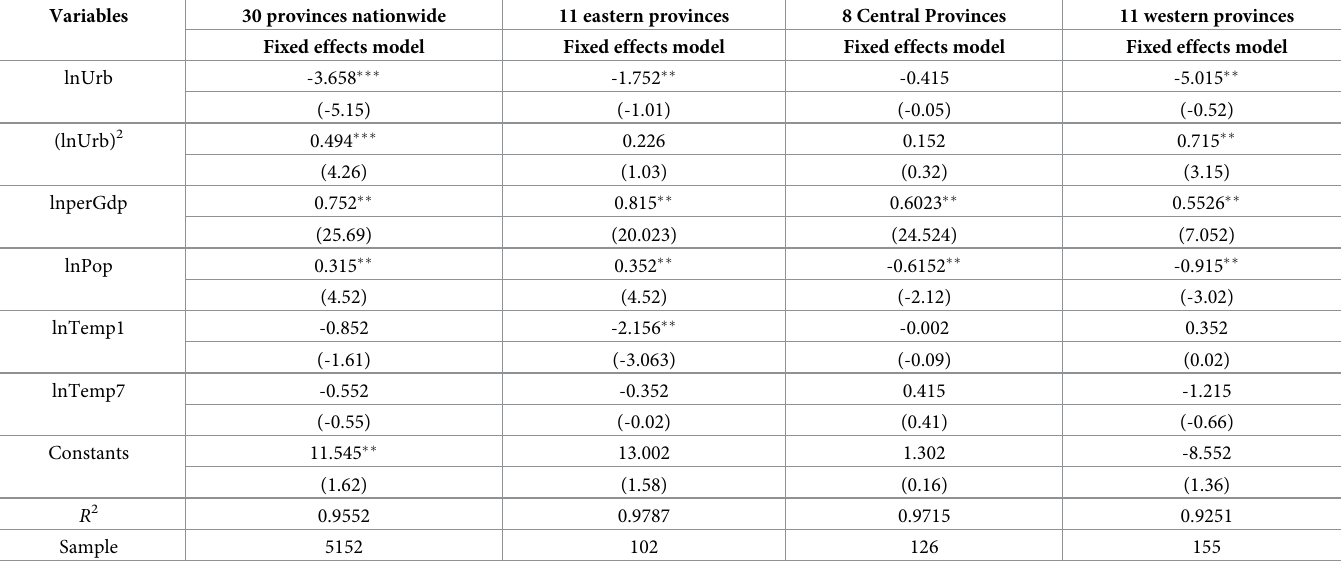
Table 6. Estimation results of the residential complete energy consumption